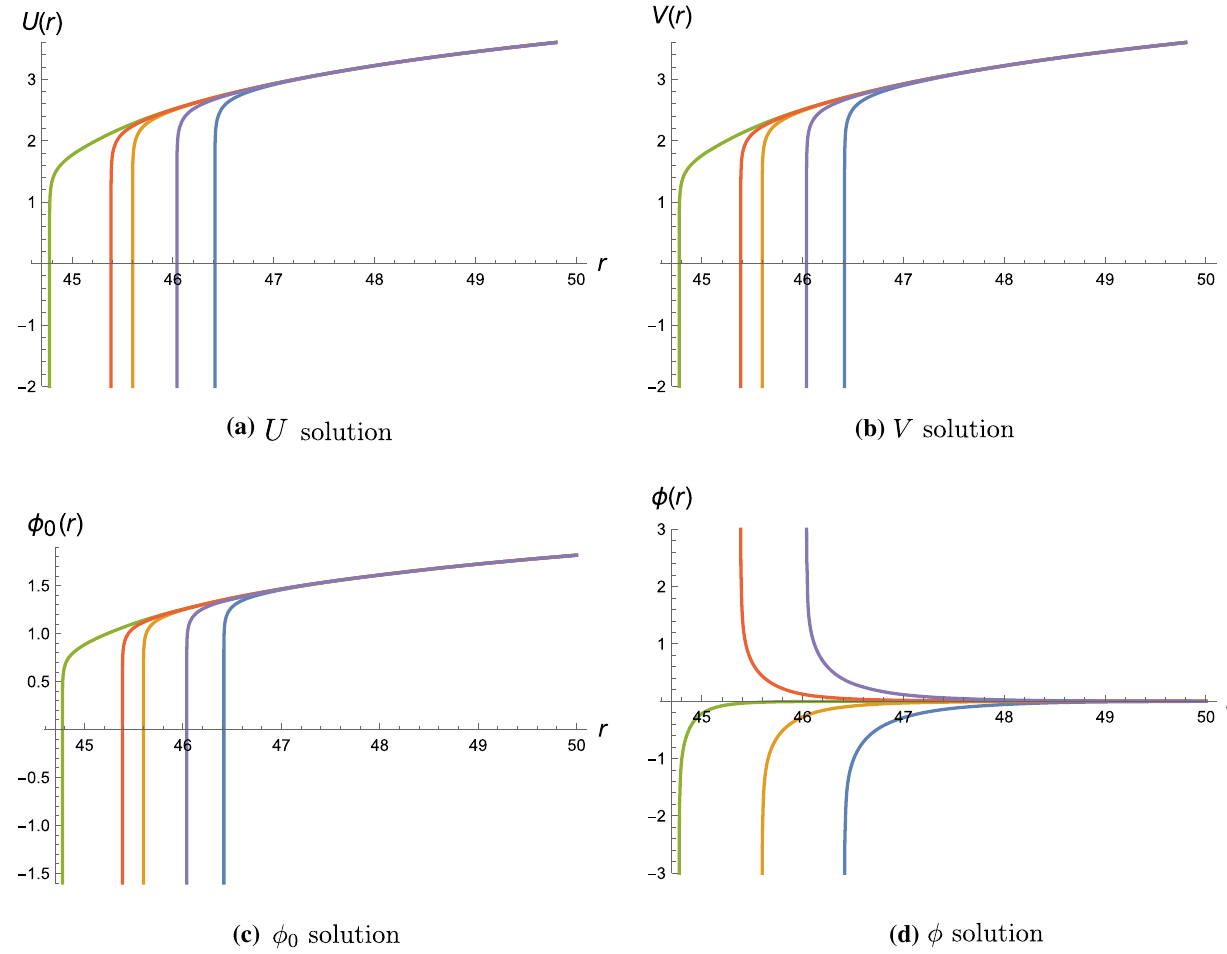
Fig. 31 Supersymmetric flows interpolating between asymptotically locally flat domain walls and Mk w 4 × S 2 -sliced curved domain walls for SO ( 2 ) × SO ( 2 ) twistin SO ( 4 ) gaugegroup.Theblue,orange,green,redandpurplecurvesreferto p 2 = − 0 . 5 , − 0 . 03 , 0 . 03 , 0 . 06 , 0 .